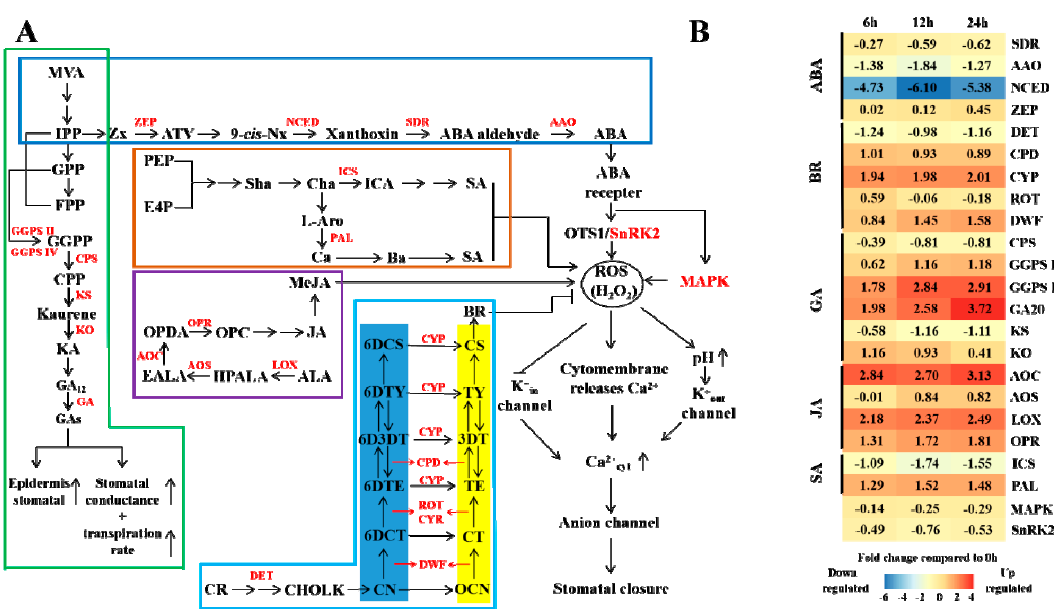
Figure 4. Influence of high CO 2 concentration on hormone and stomatal regulation. ( A ) The hormone biosynthesis pathways and stomatal regulation mechanism according to Zhao [35]. The mazarine, green, brown, purple and wathet frame represents ABA, GA, SA, JA and BR synthetic pathways, respectively. The blue and yellow block represents advanced and early C-6 oxidation pathway in BR biosynthesis, respectively. The di ff erent enzymes are shown in red font. Sharp and T -shaped arrows indicate positive and negative regulation, respectively. ( B ) Expression changes in the genes involved in metabolic pathways in response to stress. White indicates no change, red up-regulation, and blue down-regulation in each treatment, as shown in the color bar for a log 2 fold change scale. The abbreviations in the figure are shown in Table A2 from Appendix A.